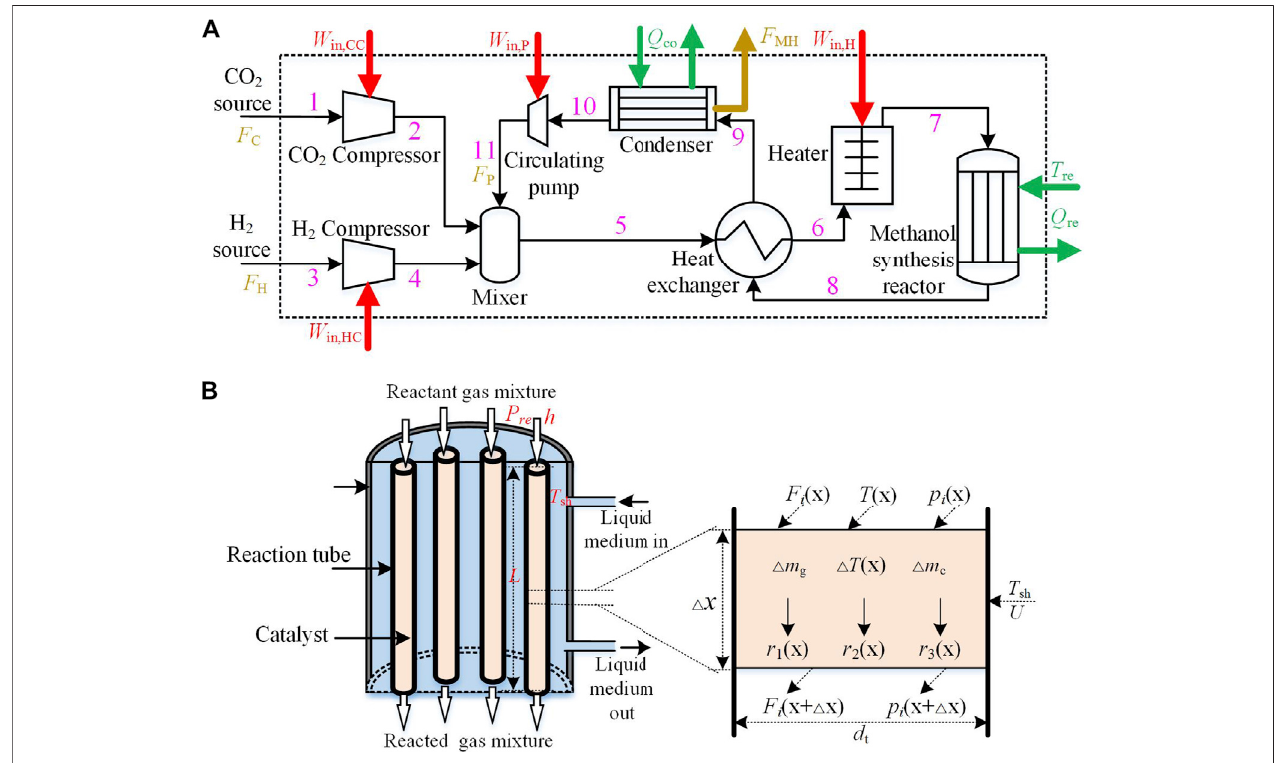
FIGURE 1 | (A) The schematic diagram of the CDHM system; (B) The schematic diagram of methanol synthesis